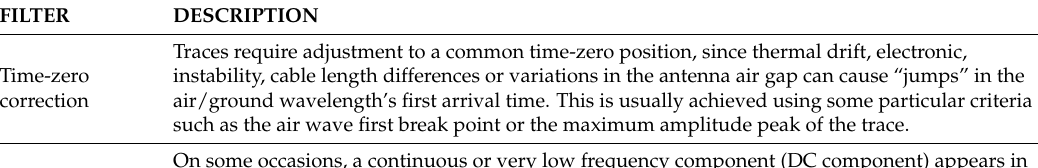
Table 1. Filters and parameters used for data processing in the case study of the Roman Site “ Aquis Querquennis